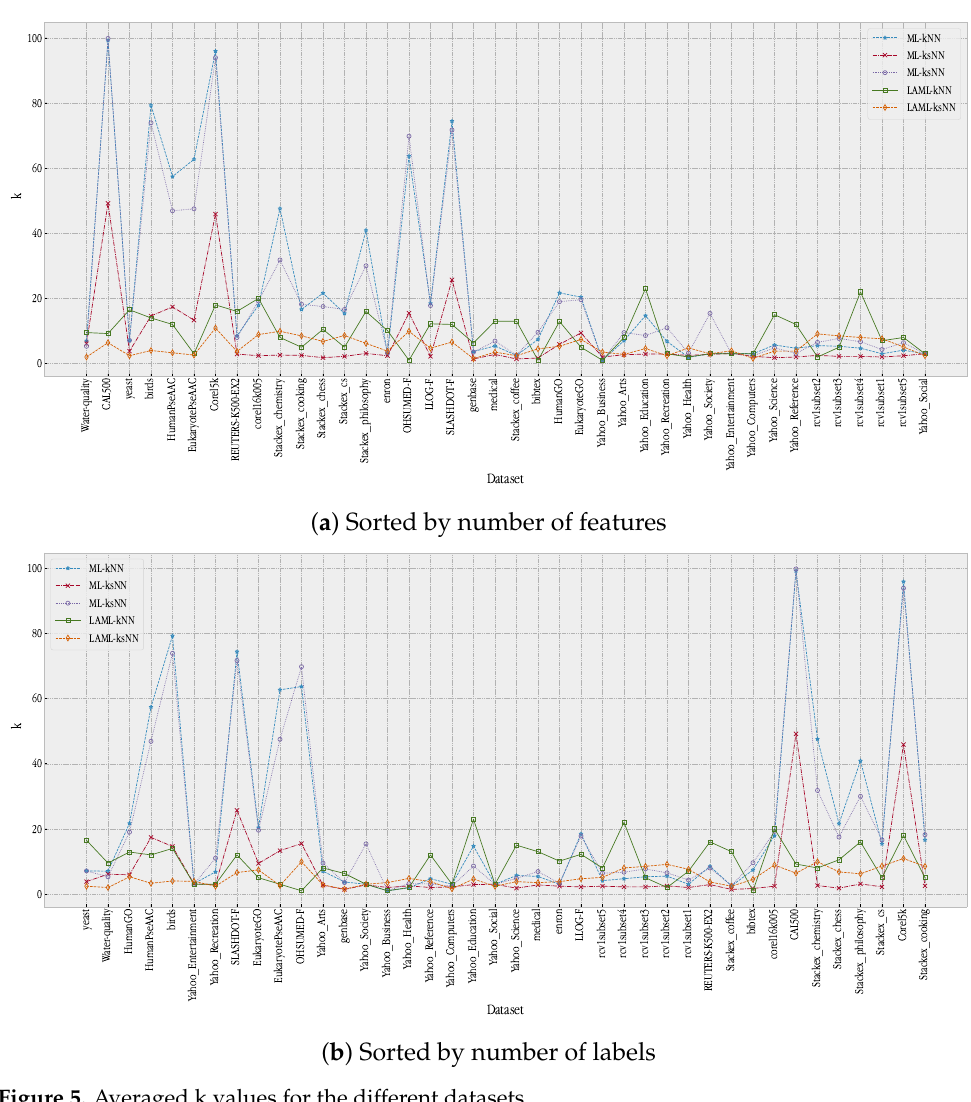
( b ) Sorted by number of labels Figure 5. Averaged k values for the different datasets.